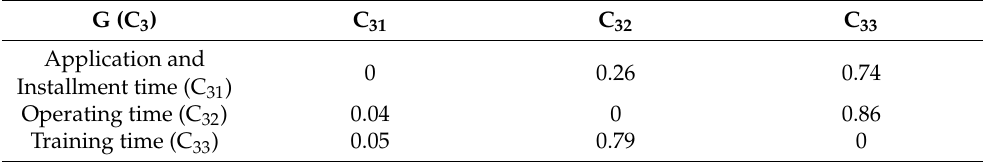
Table 13. Normalized direct influence matrix T between Time (C 3 ) sub-criteria.